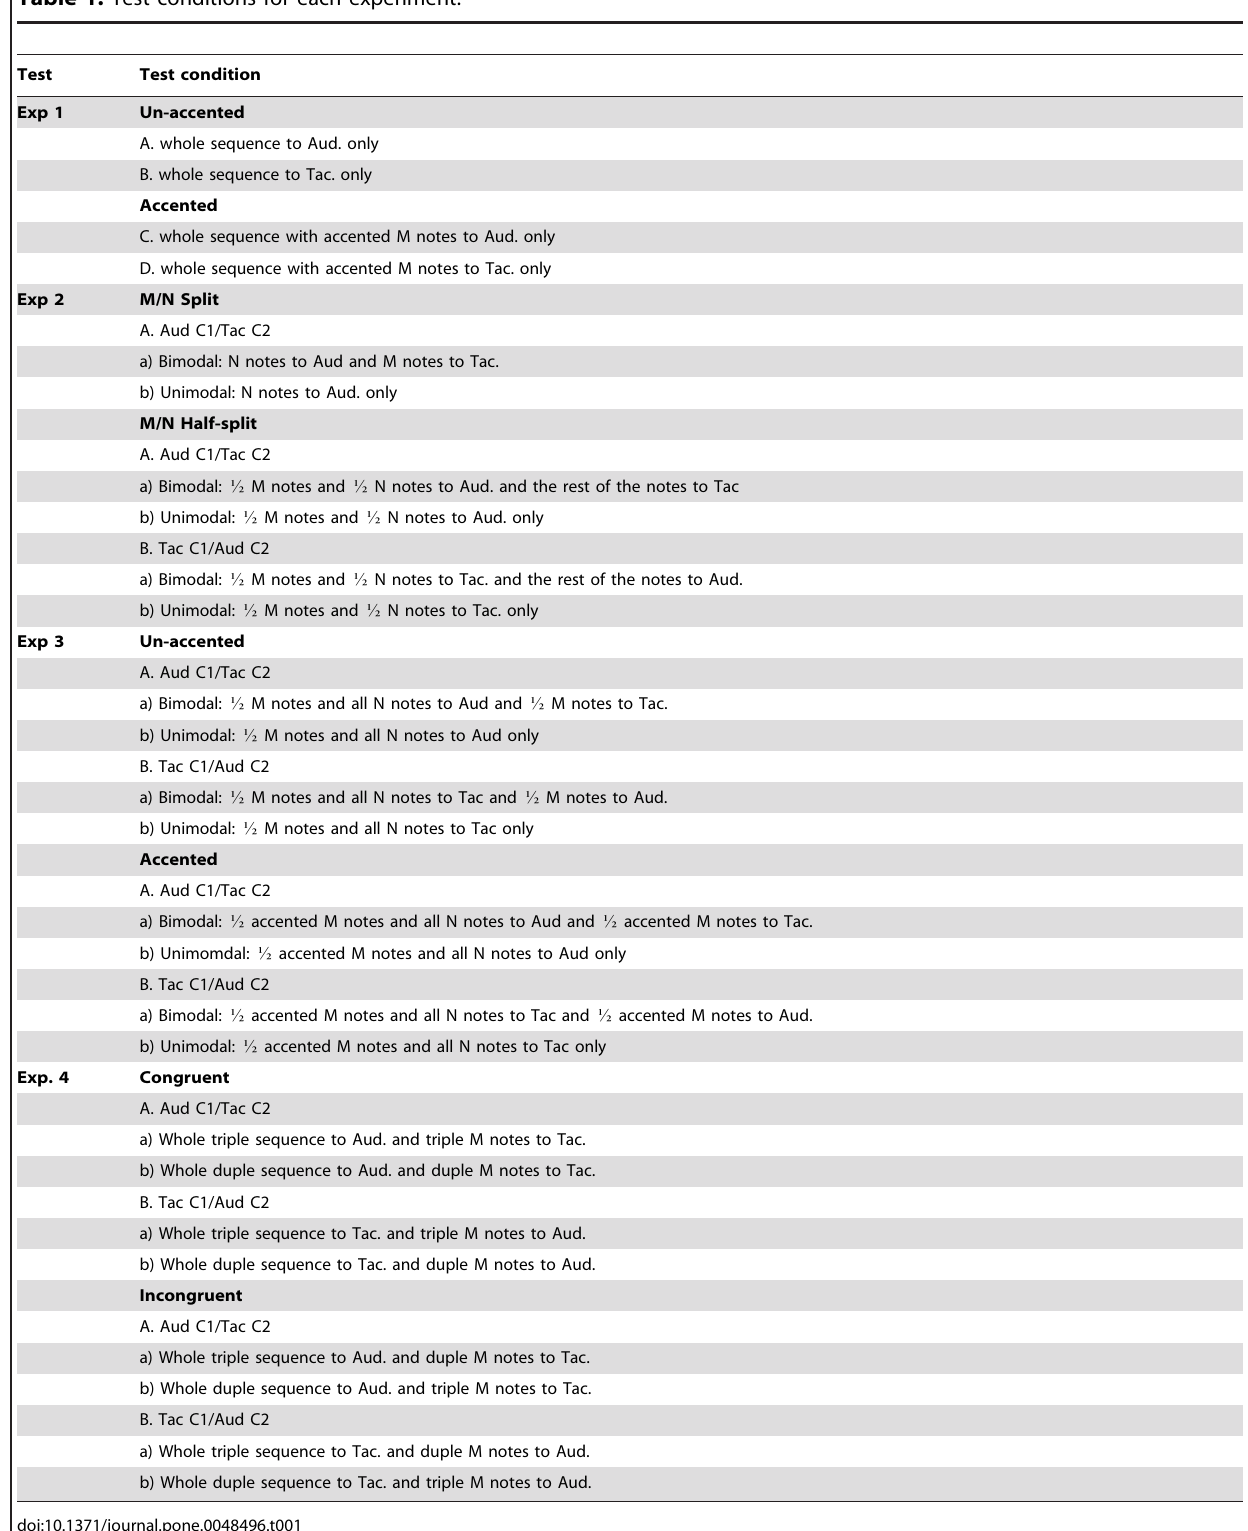
Table 1. Test conditions for each